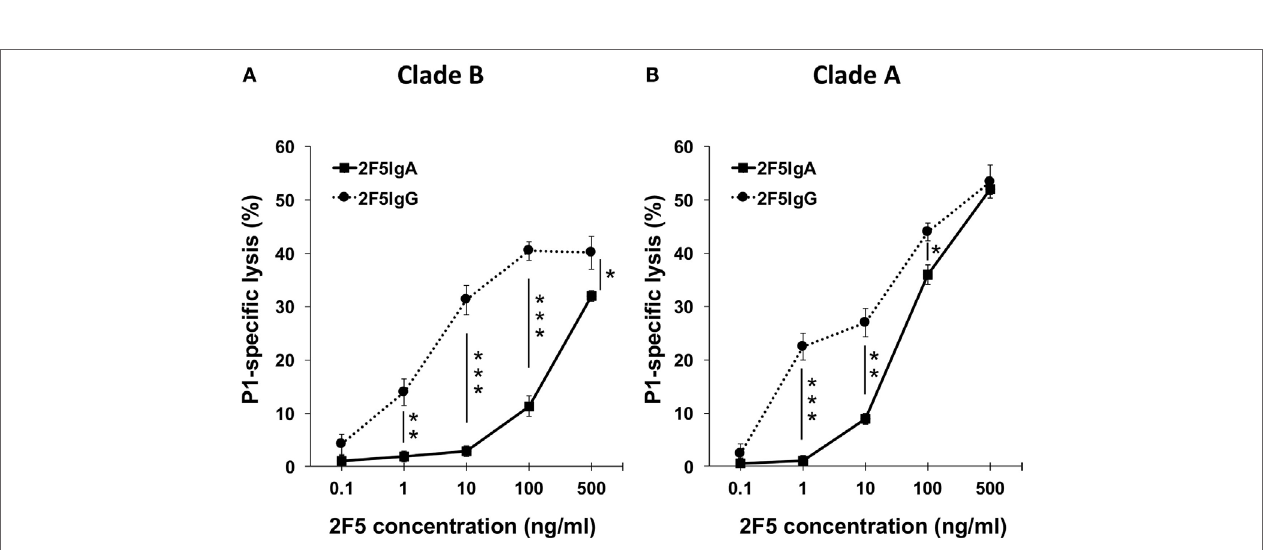
FigUre 3 | 2F5-IgA and 2F5-IgG induce the lysis of P1-A- and P1-B-coated cells in a dose-dependent manner. The efficacy of 2F5-IgA (solid line, square) and 2F5-IgG (dotted line, circle) to induce the lysis of P1-B (a) , and P1-A coated cells (B) was evaluated by flow cytometry. Target P1 Clade A and B cells were double stained with PKH26 and carboxyfluorescein diacetate succinimidyl ester and then incubated with the indicated concentrations of 2F5-IgA or 2F5-IgG for 30 min at room temperature (RT), prior to addition of effector monocytes (effector/target ratio: 10:1). Specific lysis determined as we reported (9) is plotted as a function of 2F5 antibody (Ab) concentration (ng/ml). Values represent mean ± SEM, showing the percentage of specific Ab-dependent cellular cytotoxicity (ADCC) killing derived from five independent experiments performed in duplicate. * p < 0.05, ** p < 0.02, and *** p < 0.005, unpaired Student’s t -test of 2F5-IgA versus 2F5-IgG mediated ADCC.